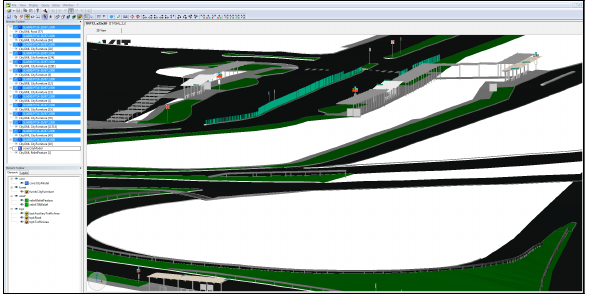
Figure 8. A sample of LOD 2 City Furniture models